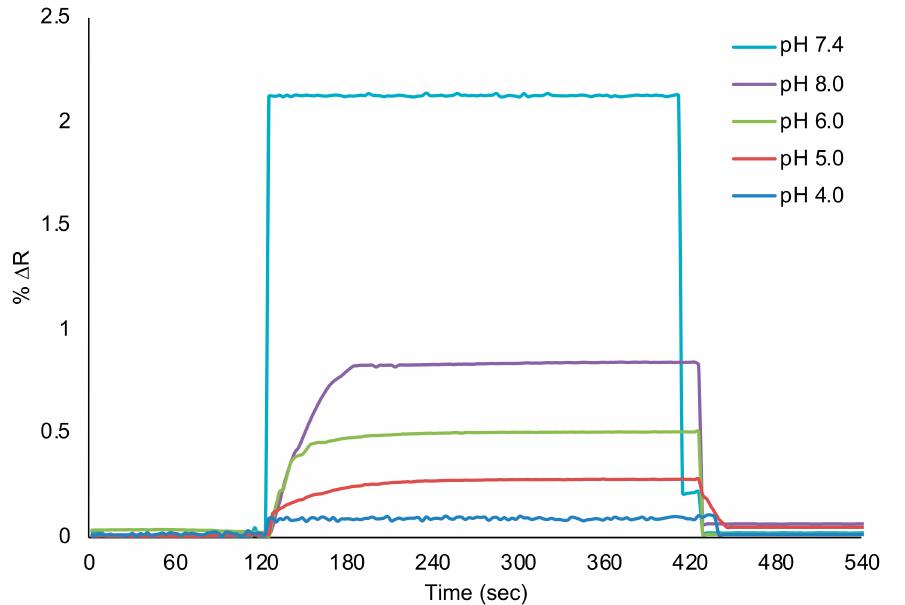
Figure 5. pH analysis for L -Phe imprinted SPR